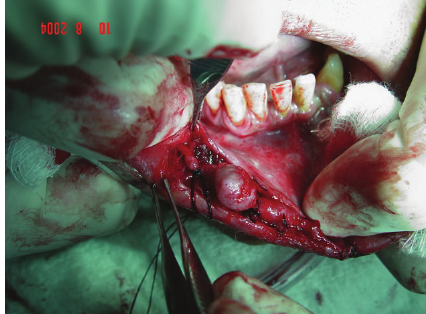
Figure 8: Specimen containing the ligature threads of the main branch.